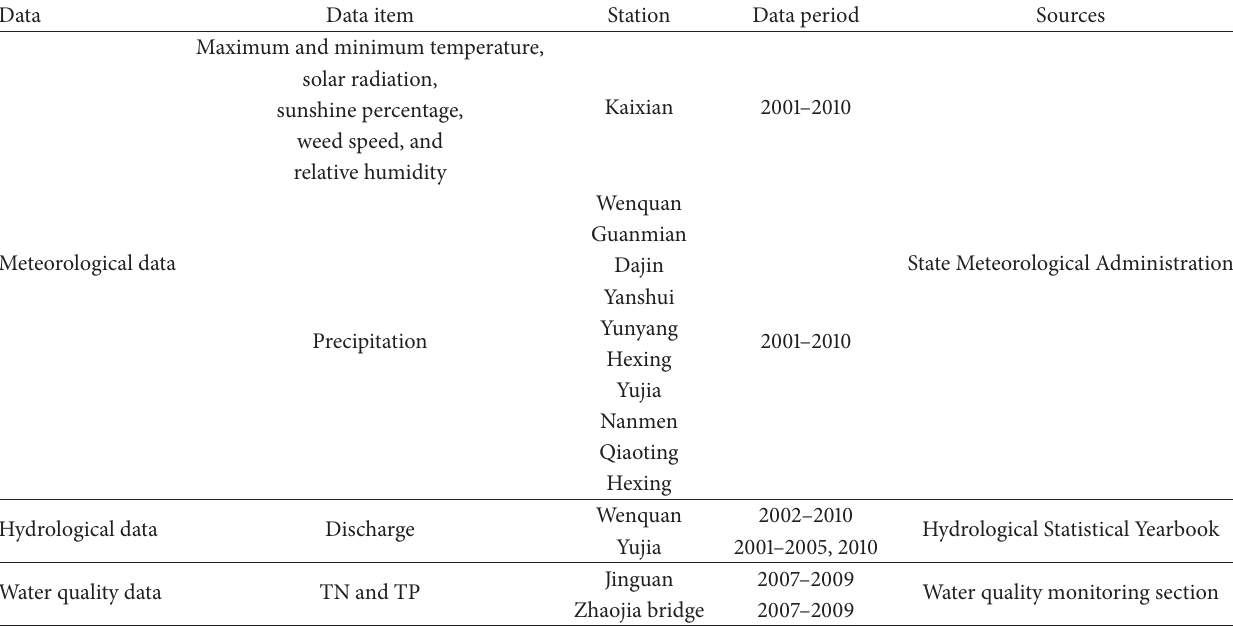
Table 2: Main data sources.